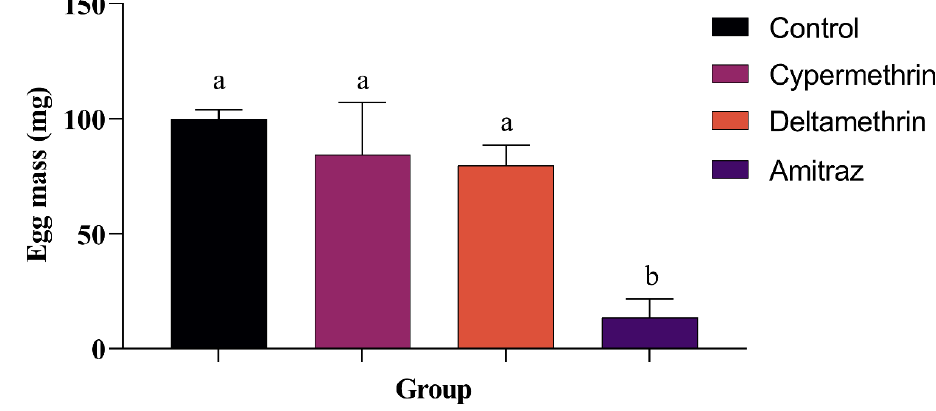
Figure 2. Comparison of average egg mass weight between groups. Columns with different letters differed significantly ( p < 0.01). Table 2. Reproductive parameters of R. microplus ticks after the adult immersion test with different acaricidal acaricide products.